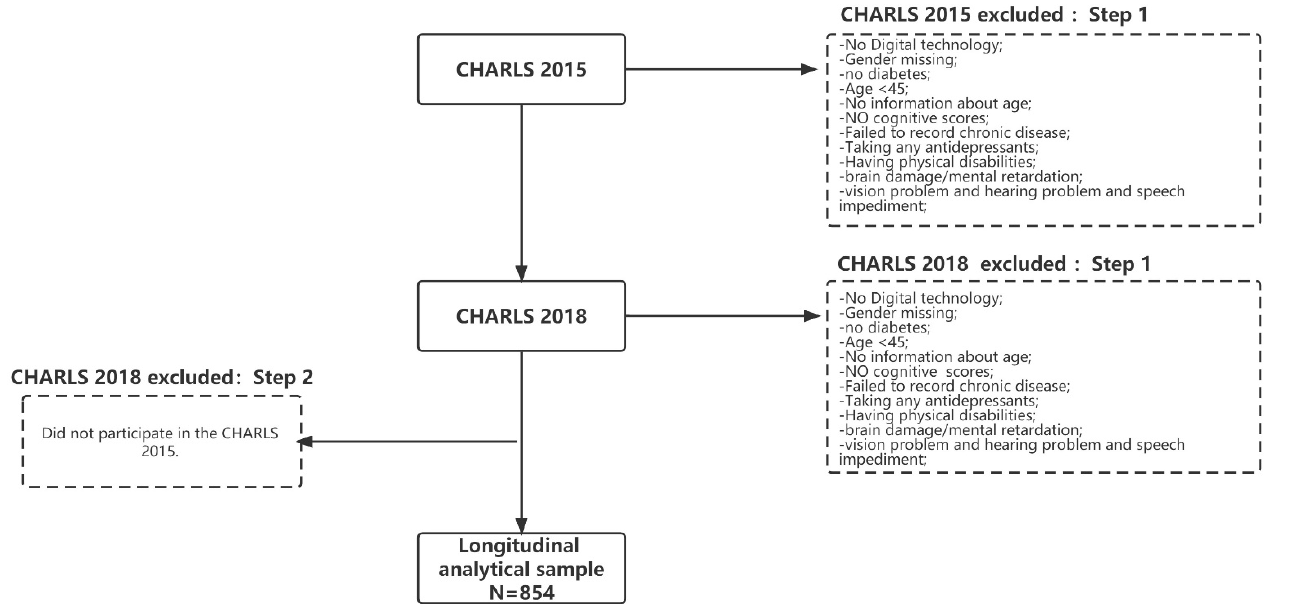
Figure 1. Sample Selection ( n = 854). CHARLS, The China Health and Retirement Longitudinal Survey.